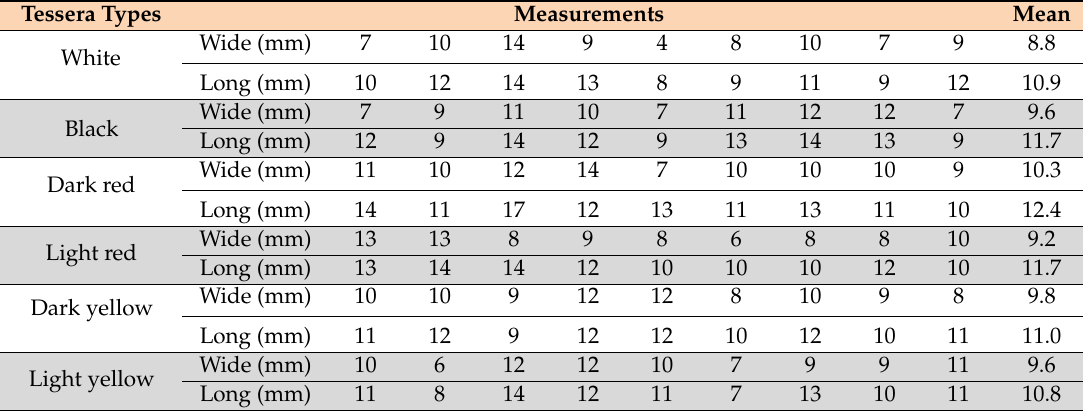
Table 4. Measurements of various tesserae to determine the average